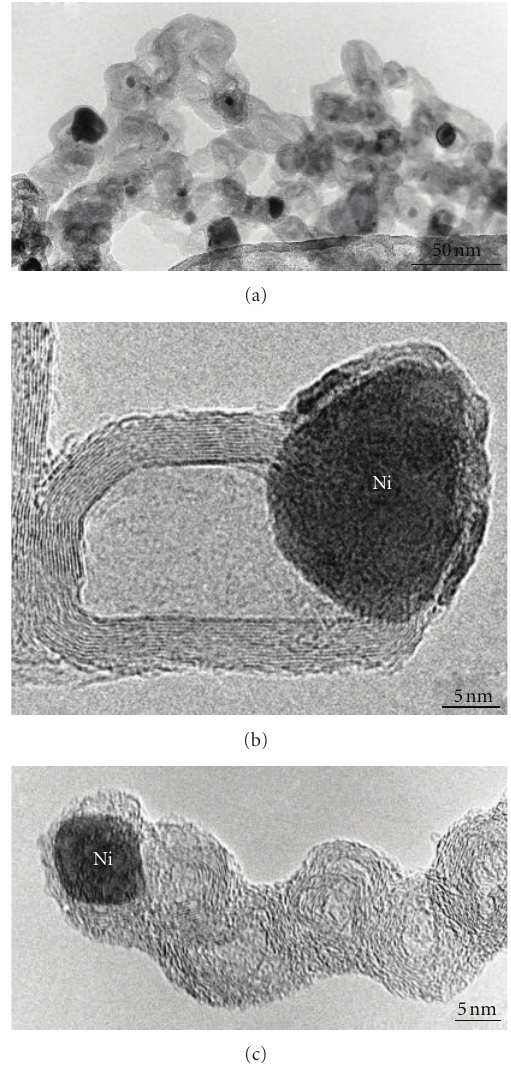
Figure 4: (a) Bright-field images of Ni-encapsulated carbon nano- capsules prepared by heating Ni-doped C 60 nanowhiskers (speci- men A) at 973 K. (b) High-resolution image of Ni-encapsulated carbon nanocapsule. (c) High-resolution image of chain of Ni- encapsulated carbon nanocapsules.